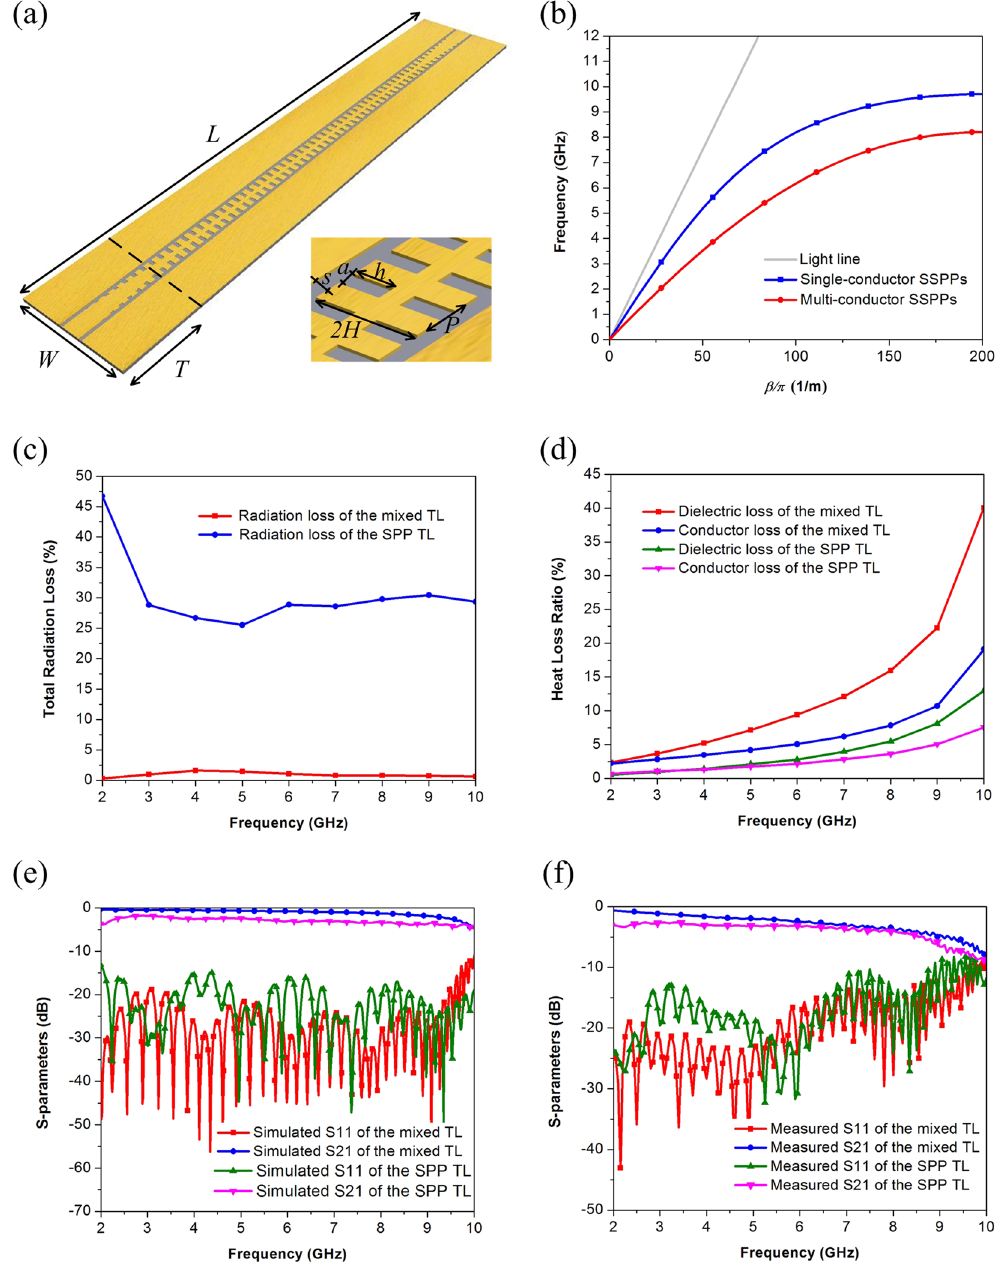
Figure 10. ( a ) The configuration of the mixed TL in which L = 325 mm, W = 60.8 mm, T = 60 mm and the F4b substrate is 0.5 mm thick. The inset picture shows the structure of the unit cell, in which P = 5 mm, a = 2 mm, h = 4 mm, H = 5 mm, S = 0.4 mm. ( b ) Dispersion diagrams. ( c ) Total radiation loss. ( d ) Dielectric loss and conductor loss. ( e ) Simulated S-parameters. ( f ) Measured